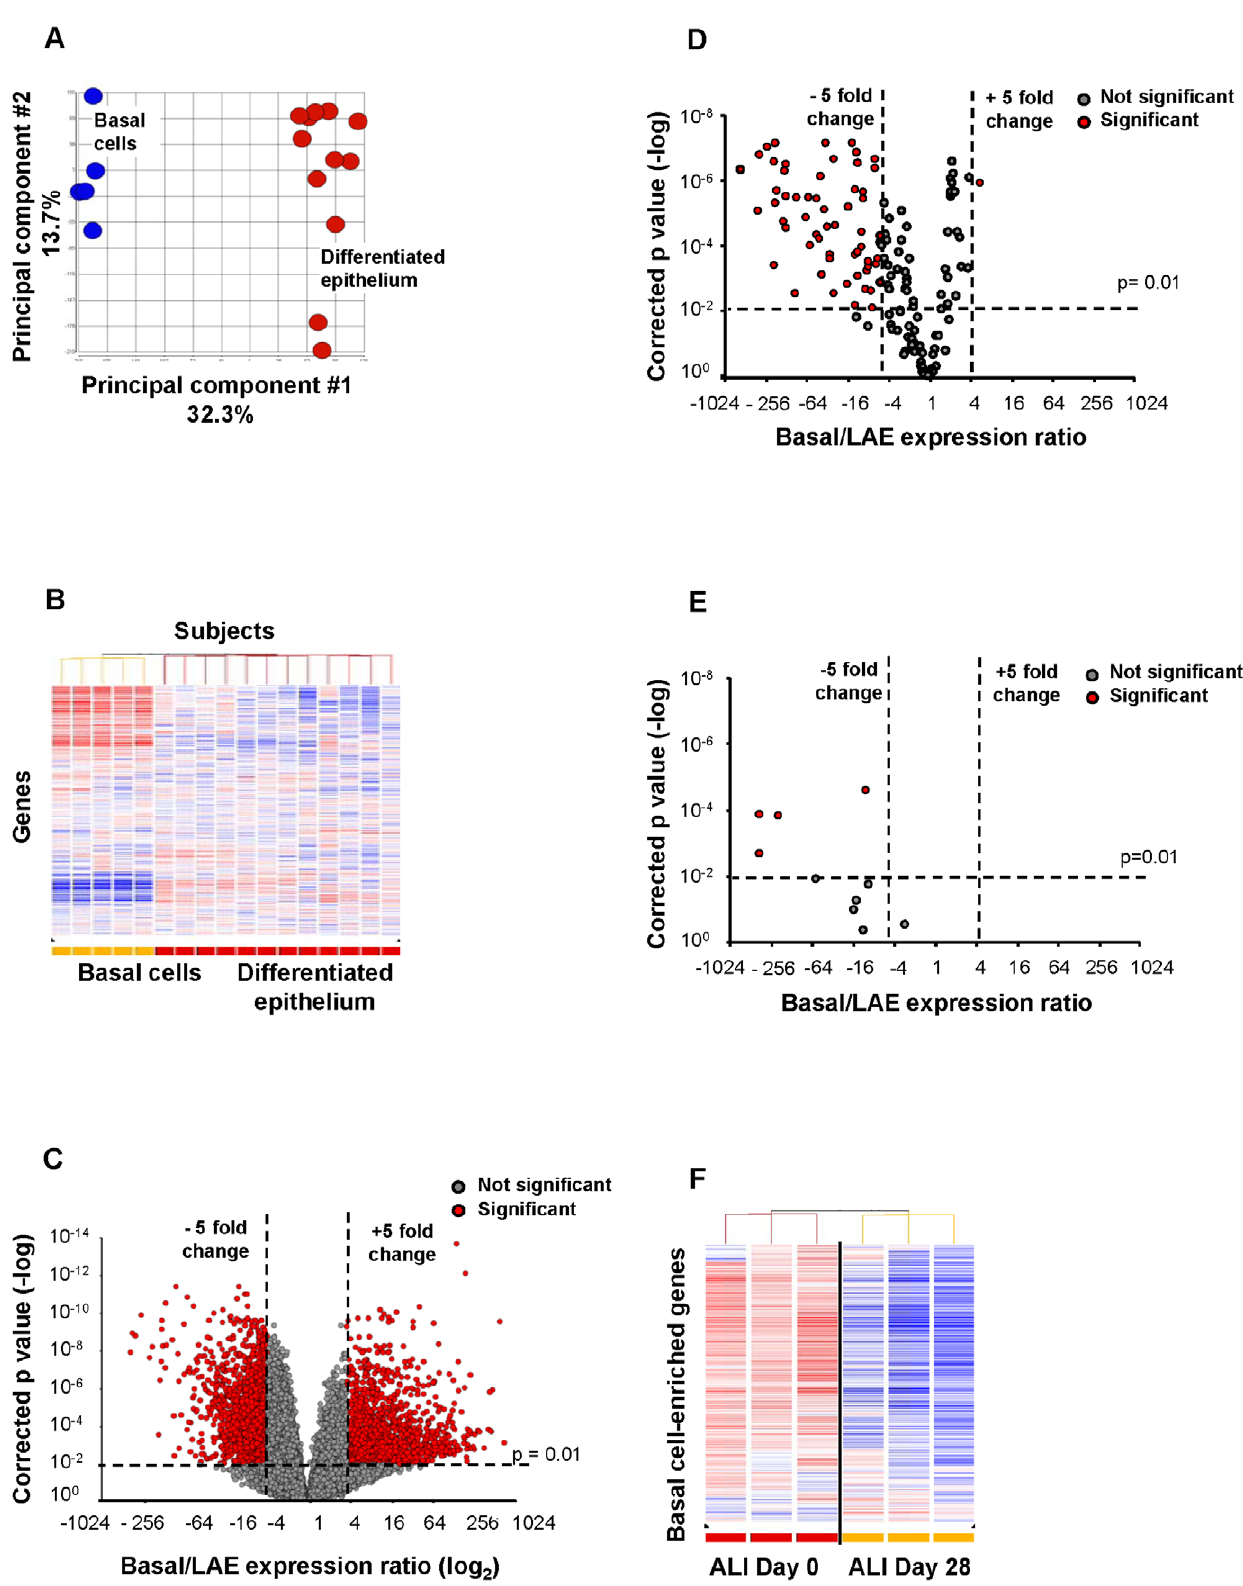
Figure 2. Identification of basal cell-enriched transcripts. A. Principal component analysis of gene expression of basal cells (n=5; blue circles) and differentiated airway epithelium samples (n=12; red circles) using all expressed gene probe sets (n=39,324) as an input dataset. B. Hierarchical cluster analysis of basal cells (n=5) compared to complete airway epithelium samples (n=12) based on the expression of 1,000 randomly chosen probe sets detected in either of groups. Genes expressed above the average are represented in red, below average in blue, and average in white. The